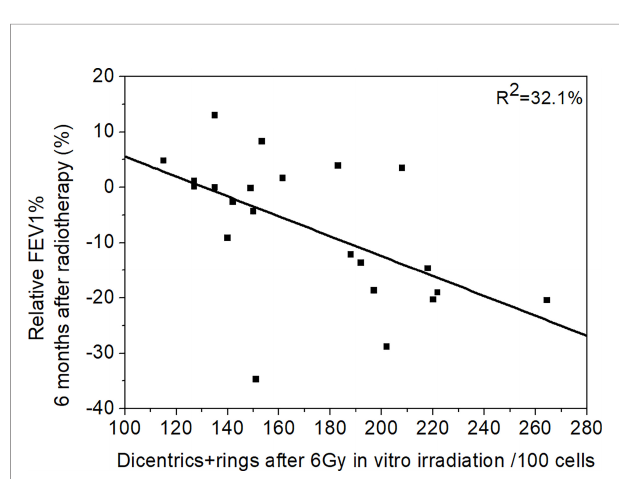
FIGURE 4 | The connection of chromosome aberrations and pulmonary function. The connection between the relative FEV1% 6 months after the radiotherapy and dicentrics and rings after 6 Gy in vitro irradiation. The FEV1% decrease is bigger when there are more chromosome aberrations in the in vitro -irradiated blood. Regression line was fi tted ( R 2 =